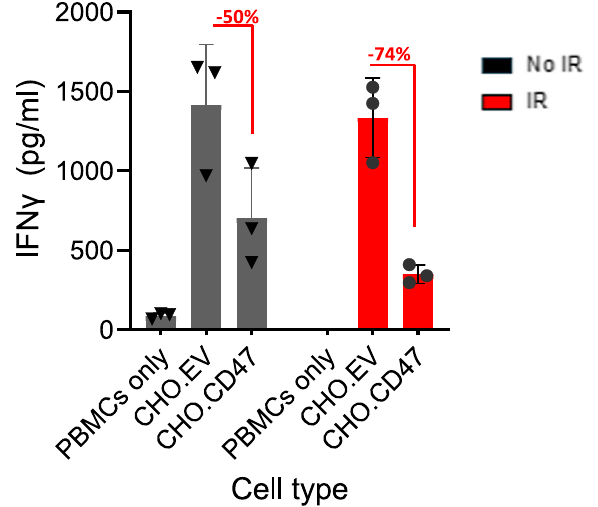
Fig. 7 CD47-dependent T cell inhibition is enhanced upon irradiation. CHO_EV and CHO_CD47 cells were either untreated or irradiated and were allowed to rest for 6 h. Then, cells were co-cultured with PBMCs. After 72 h, conditioned media were collected and analyzed for IFN γ secretion. The level of IFN γ secreted by PBMC cultured in the absence or presence of the CHO cells, is presented. Graph shows an average (± STD) of triplicate samples in each group. Representative of three experiments using three independent blood donors is